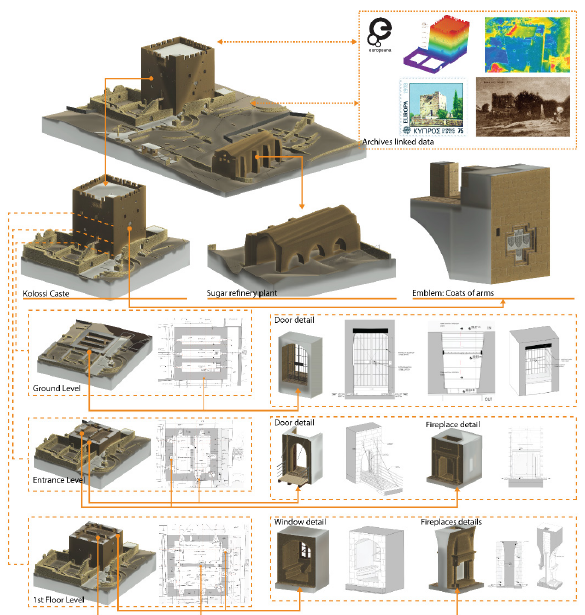
Figure 16. Kolossi Caste Collection sample map shows the glTF previews along with 2D drawings and details and linked with online archives data such as images, stamps, static analysis data, point clouds and thermal